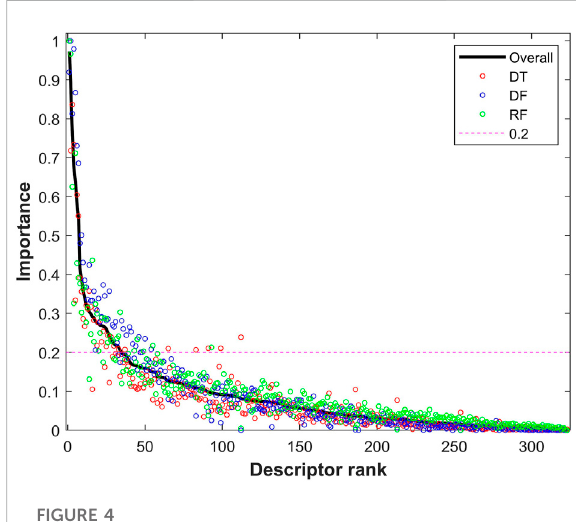
FIGURE 4 Importance of descriptors from tree-based models. The x -axis represents the rank of descriptors, while the y -axis indicates importance of descriptors. The importance values from decision tree (DT), decision forest (DF), and random forest (RF) are plotted as red, blue and green circles, respectively. The black solid linerepresentsthecombinedoverallimportance.Thereddashline marks the threshold of importance for descriptor